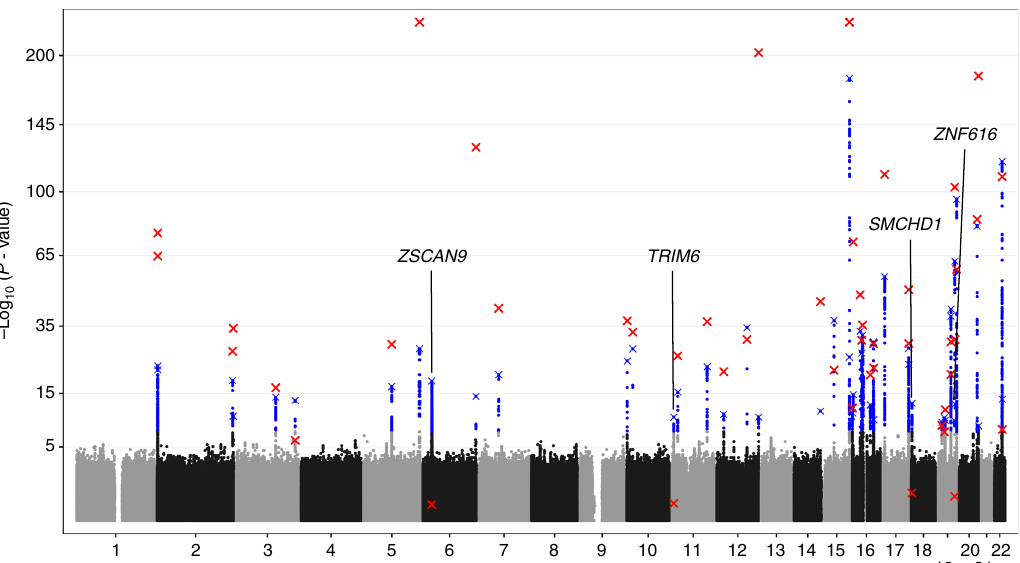
Fig. 1 Manhattan plot showing all tested autosomal SNPs for an overall effect on X-chromosomal methylation in females. Signi fi cant associations are depicted in blue (Wald P < 5 × 10 − 8 ). The sentinel variant per independent locus is indicated with a blue cross. Testing the effects of these 48 sentinel variants in males, we found 44 replicated in males (Wald P < 1.1 × 10 − 6 , red cross), whereas the other 4 loci were female-speci fi c, as they clearly lacked an effect in males (Wald P > 0.19)